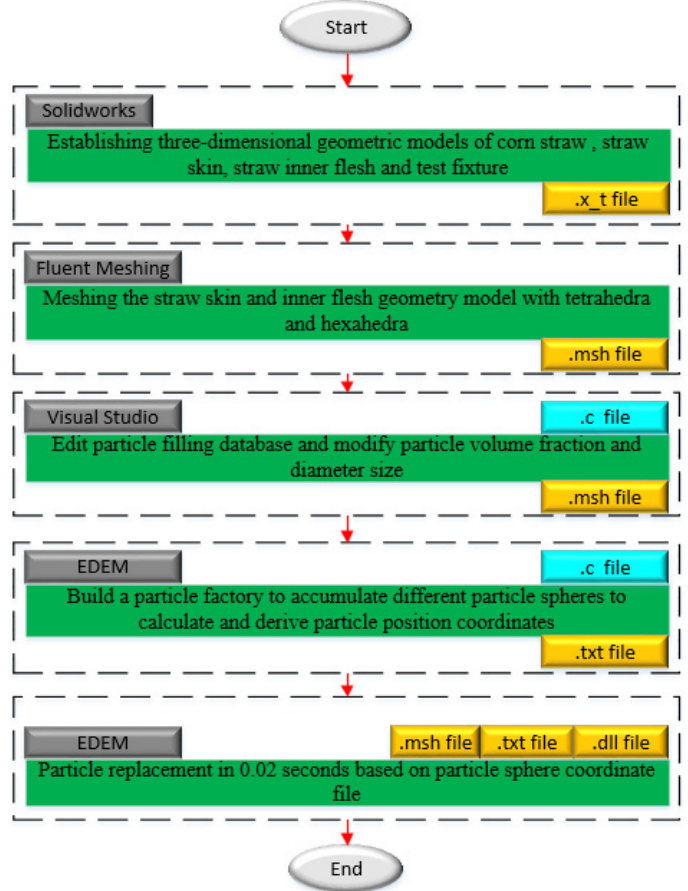
Figure 4. Method of building discrete element model of specimen.